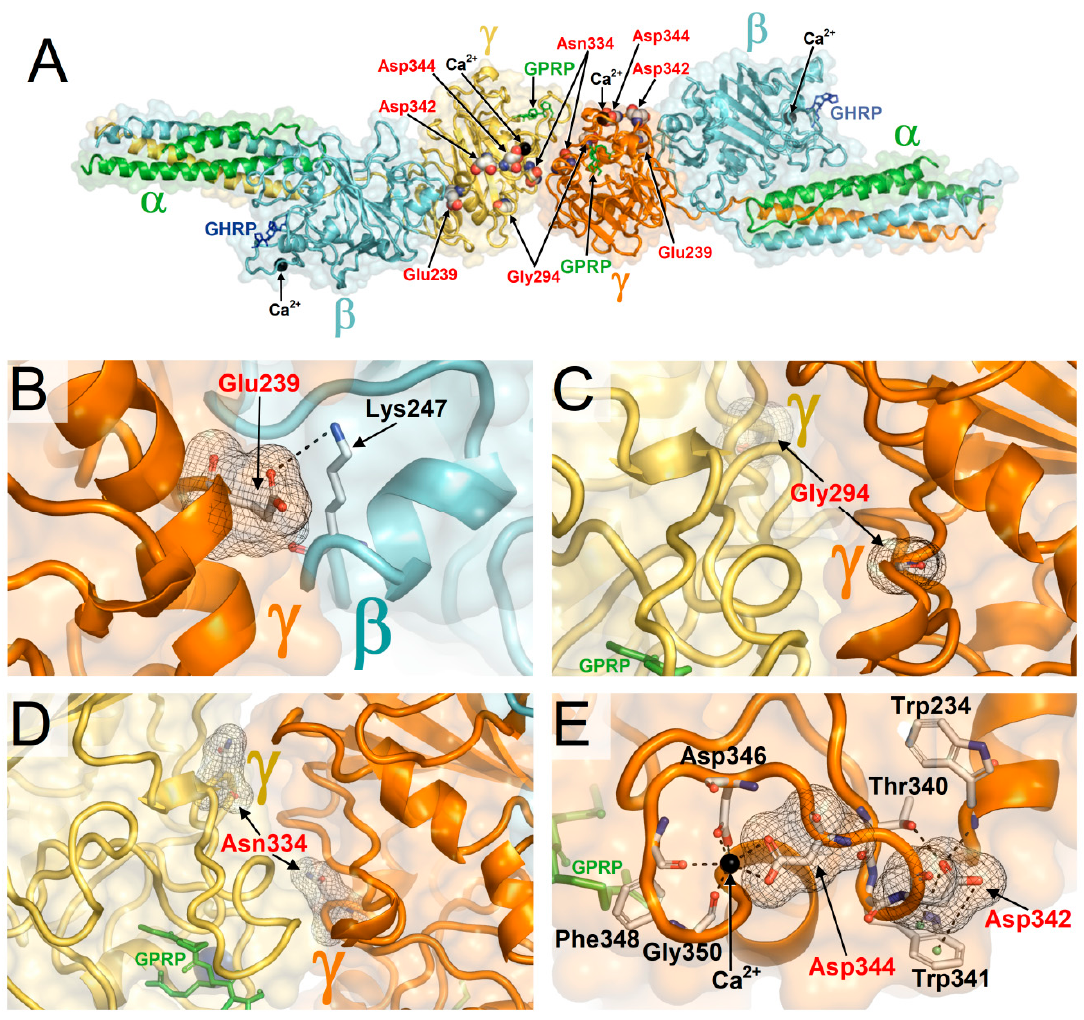
Figure 3. Amino acid residues a ff ected by the missense variants p.Glu239Ala, p.Gly294Glu, p.Asn334Ile, p.Asp342Asn, and p.Asp344Val reported by HGMD and consistently predicted by FoldX, CUPSAT, and PoPMuSiC with ∆∆ Gs producing non-significant structural changes in the γ -module. ( A ) The a ff ected sites are shown on the crystal structure of fragment double-D from human fibrin (PDB 1FZC) to highlight their importance in intermolecular interactions. GPRP is an analogue of the α chain knob. GHRP represents the β chain knob. ( B ) Detailed view of the site a ff ected by the p.Glu239Ala variant. The wild type glutamic acid does not contribute significantly to the γ -module fold but is critical for its intermolecular interaction with the β chain via a salt-bridge (dotted lines) with Lys247 in the latter protein. ( C ) Site a ff ected by the p.Gly294Glu variant. The wild-type glycine has no important role in the γ -module fold but is located at the D-D interaction interface which is altered by the non-conservative replacement with glutamic acid. ( D ) Site of the p.Asn334Ile variant. The hydrophilic wild type asparagine is located at the D-D interaction interface; its replacement with the hydrophobic isoleucine alters the properties of the D-D interface. ( E ) p.Asp342Asn and p.Asp344Val variants. Asp342 is engaged in a number of intramolecular interactions (dotted lines), which might be at least partially maintained by the quite conserved replacement with an asparagine. The residue is also close to the Ca 2 + ion cofactor binding site. Being the a ff ected site at the γ -module surface, it might not cause a severe misfolding. However, this site is not distant from the bound β chain and therefore p.Asp342Asn might a ff ect the interactions with this protein. The p.Asp344Val variant a ff ects an aspartic residue whose carboxylic side chain coordinates the Ca 2 + ion, and this interaction is lost upon the non-conservative replacement with a valine. In this case, the localization of the change on the surface might not lead to the major unfolding of the γ -module but its intermolecular interactions with other fibrinogen chains can be altered.